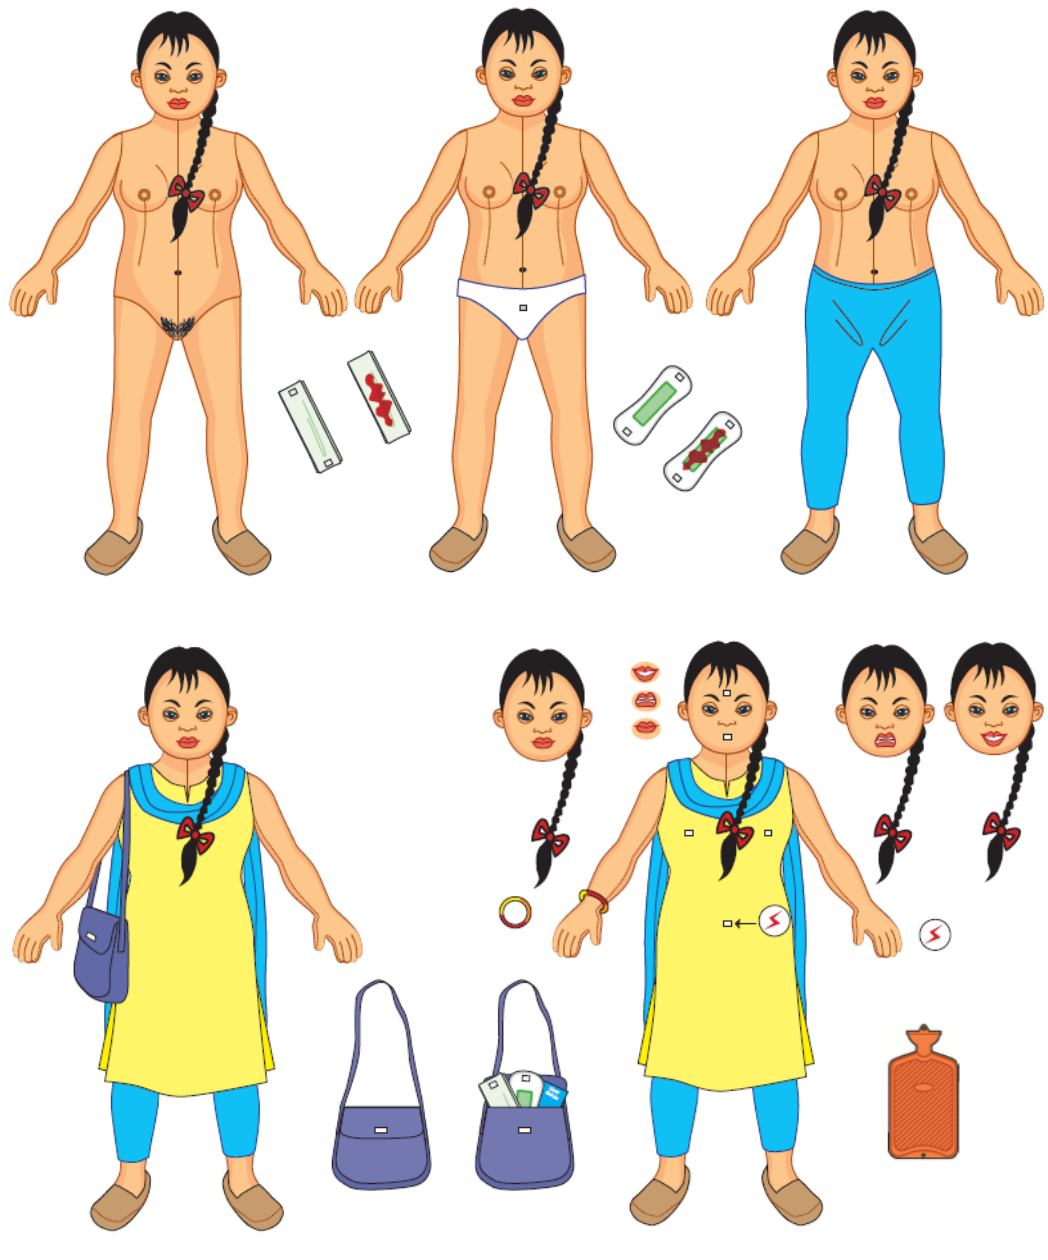
Figure 5. Large Bishesta doll.